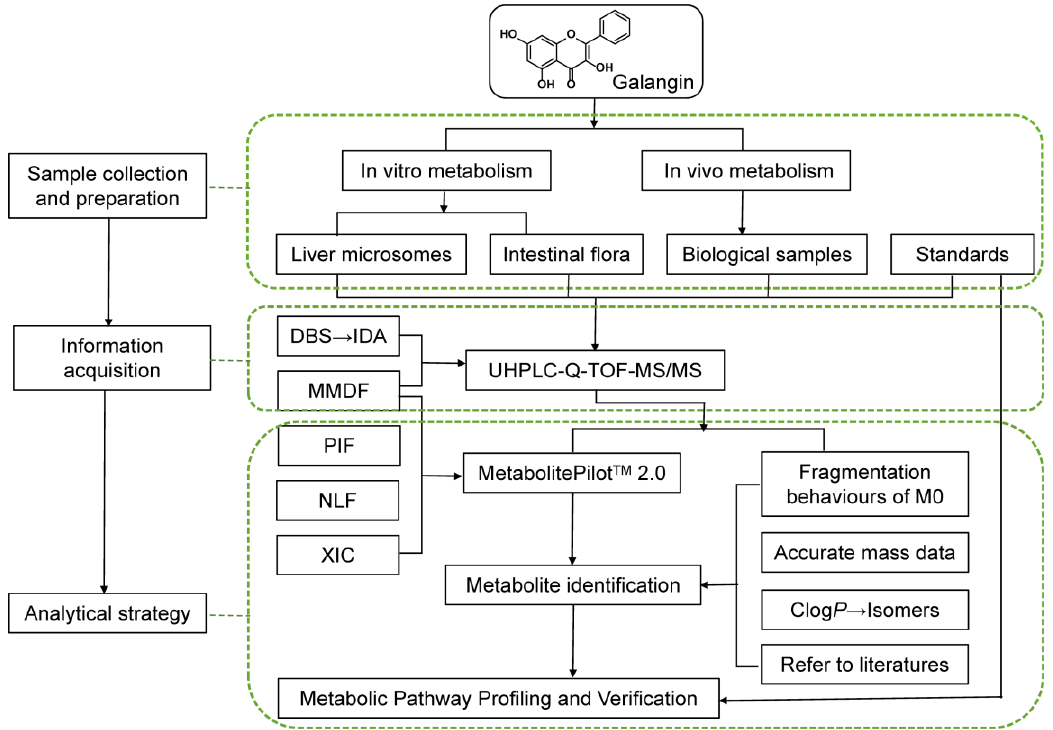
Figure 2. Work flow of the analytical procedure for identification of galangin metabolites.